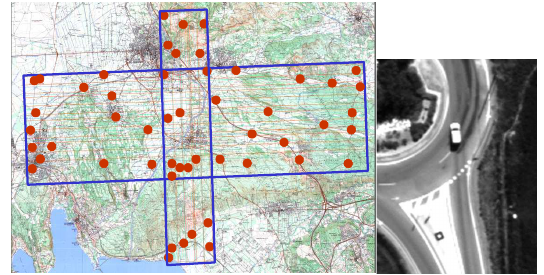
Figure 5: the geometric supersite of Salon de Provence composed of 52 GPS GCPs, 1149 aerial images and their accurate geometric model, and a 1m DSM.